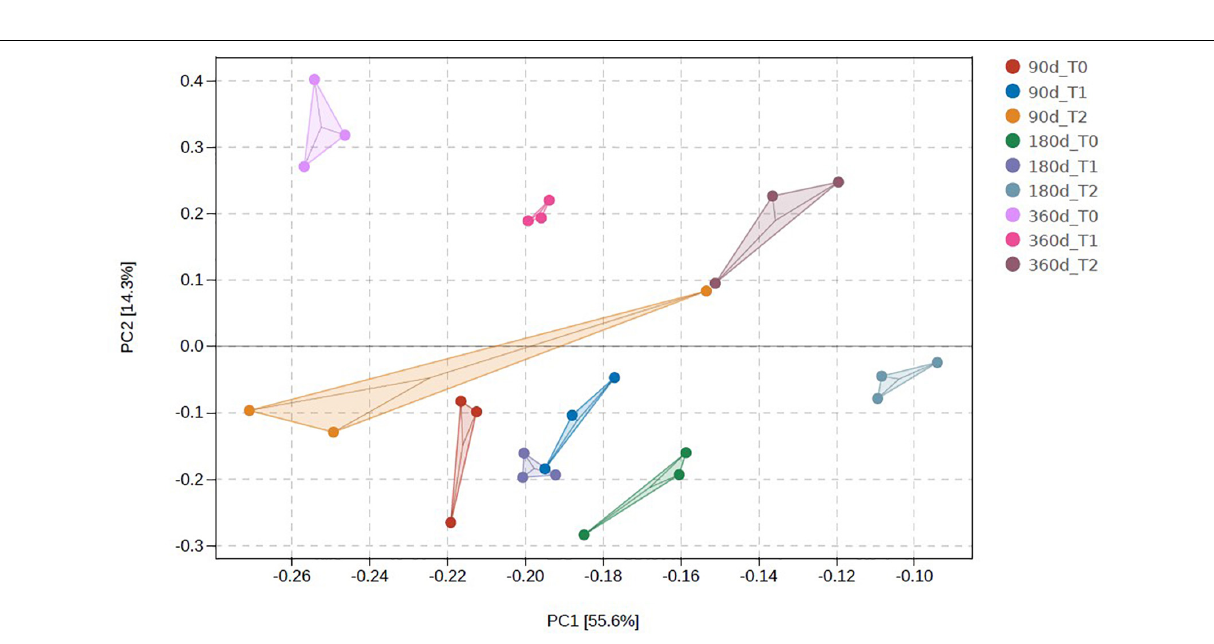
FIGURE 5 | Principal component analysis of the microbial communities in the tailing sand at the operational taxonomic unit (OTU) level. T0, iron tailing sand + soil; T1, iron tailing sand + soil + Pennisetum giganteum ; T2, iron tailing sand + soil + bio-matrix pot + Pennisetum giganteum ; 90 d, 180 d, and 360 d indicate the sampling time in days after the start of the